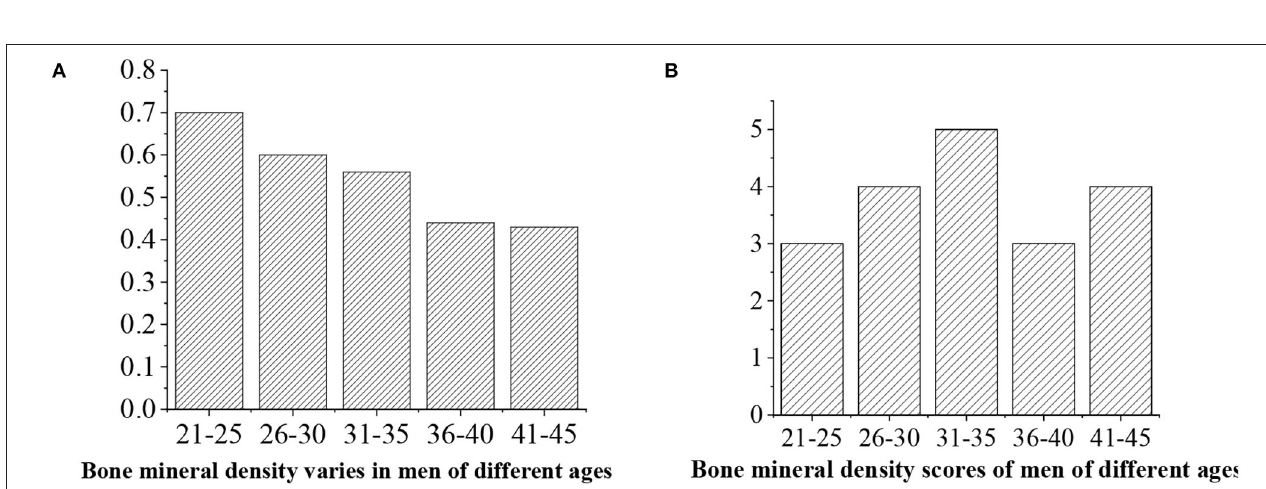
FIGURE 16 | (A) Statistical average bone density value for men of different ages. (B) Bone density score.